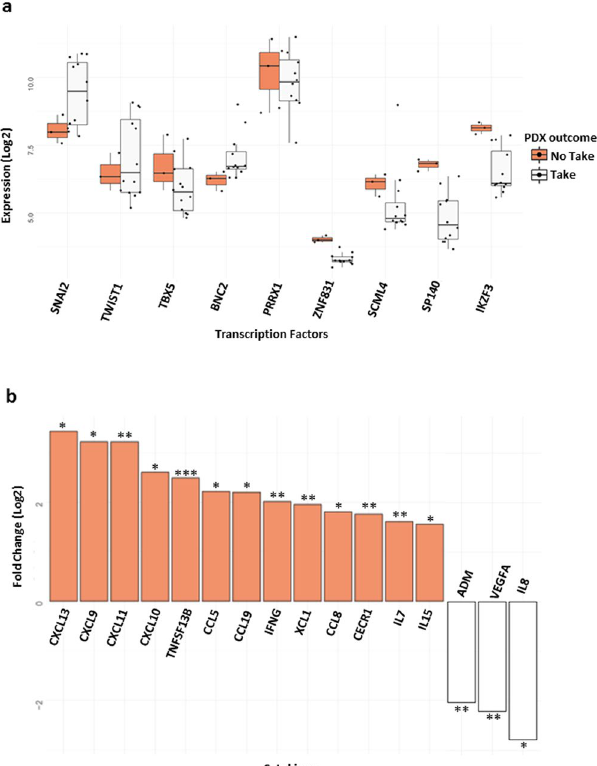
Figure 6. The association between TFs expression and the capacity to form patient-derived xenografts in Basl samples. ( a ) - Boxplot comparing the expression of the TFs of both modules in human tumour samples before implantation in the animal model ZNF831, IKZF3, and SP140 have a p < 0.05 in a t-test comparing “No take vs take” samples. TBX5, SNAI2, TWST1, BNC2 and SCML4 do not present statistical significant difference. ( b ) - histogram depicting the fold change of cytokines comparing “No take vs take” samples, with Fold Change > 1.5 and p < 0.05. “ * ” is for p < 0.05, “ ** ” for p < 0.01 and “ *** ” for p <